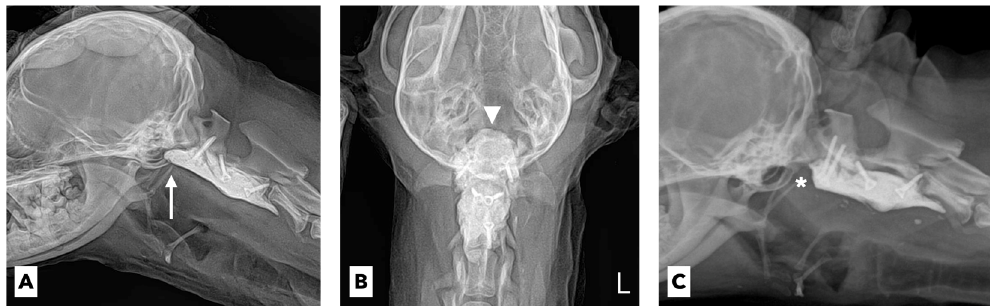
Figure 3. Radiographic images before ( A , B ) and after ( B ) revision surgery. ( A , B ) The PMMA cement protrudes beyond the level of cranial aspect of the atlas (arrow and arrowhead). ( C ) The protruded cranial part of the implanted PMMA cement was successfully removed through revision surgery (asterisk).